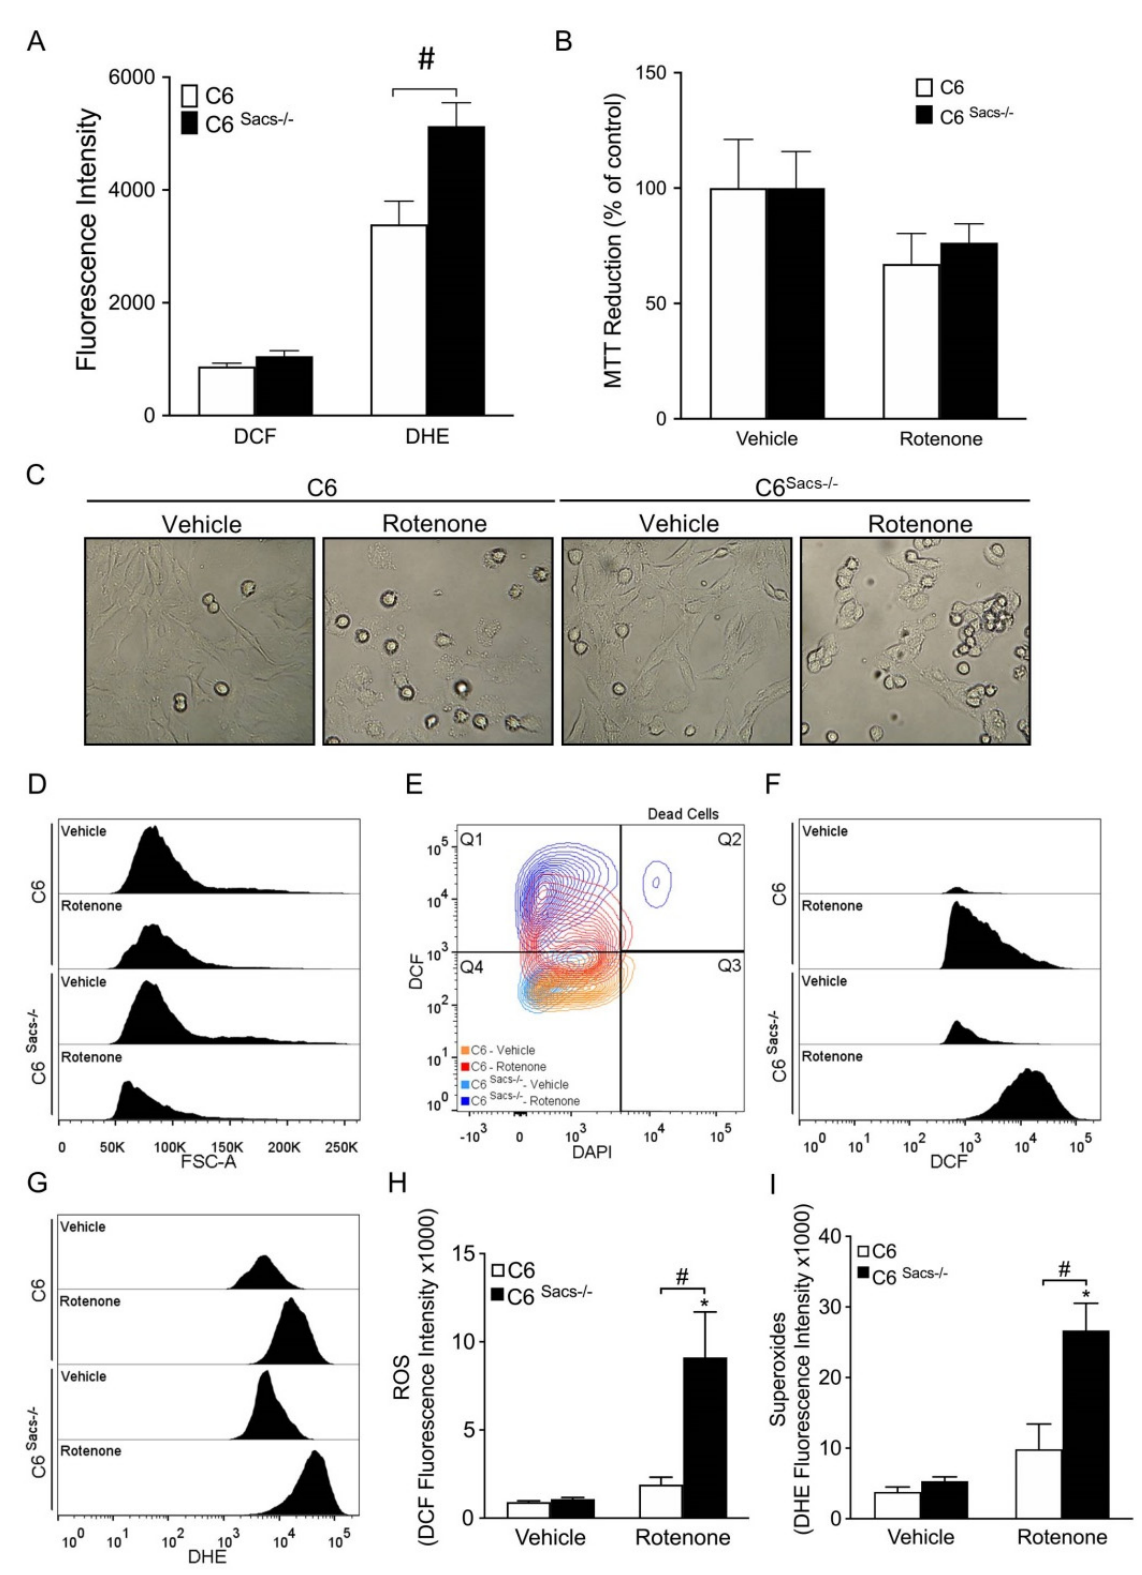
Figure 2. Sacsin knockout renders cells more sensitive to rotenone-induced stress. ( A ) Under basal conditions, C6 Sacs − / − had levels of reactive oxygen species (ROS) similar to C6 cells, as determined by DCF fluorescence. However, C6 Sacs − / − showed higher levels of superoxide radicals, as